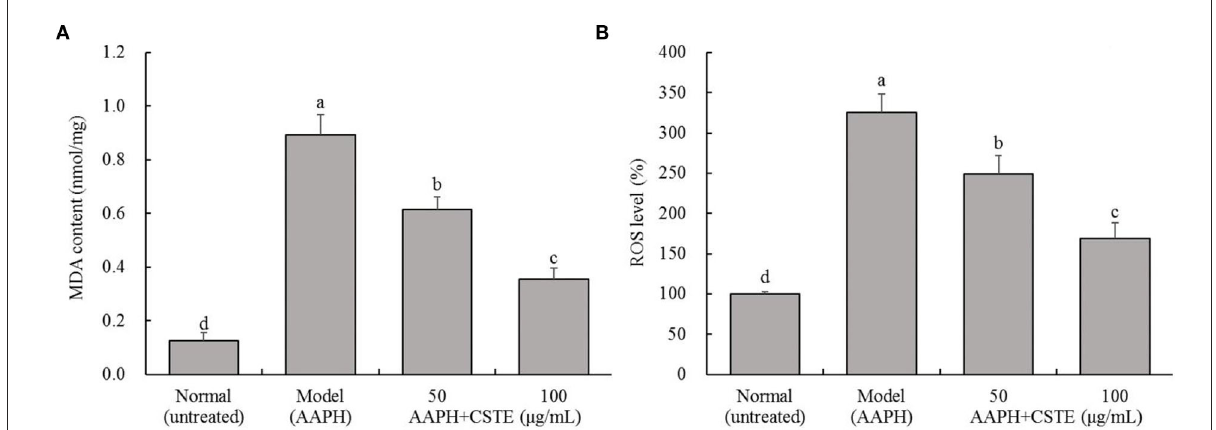
FIGURE3 MDA content and ROS level of AAPH inducing oxidative damaged HL-1 cardiomyocytes, (A) MDA content, (B) ROS level; CSTE: Clerodendranthus spicatus (Thunb.) C. Y. Wu extract. a − d according to Duncan’s multi range test, the average values of different letters in the same column have significant differences ( P < 0.05, n = 6).